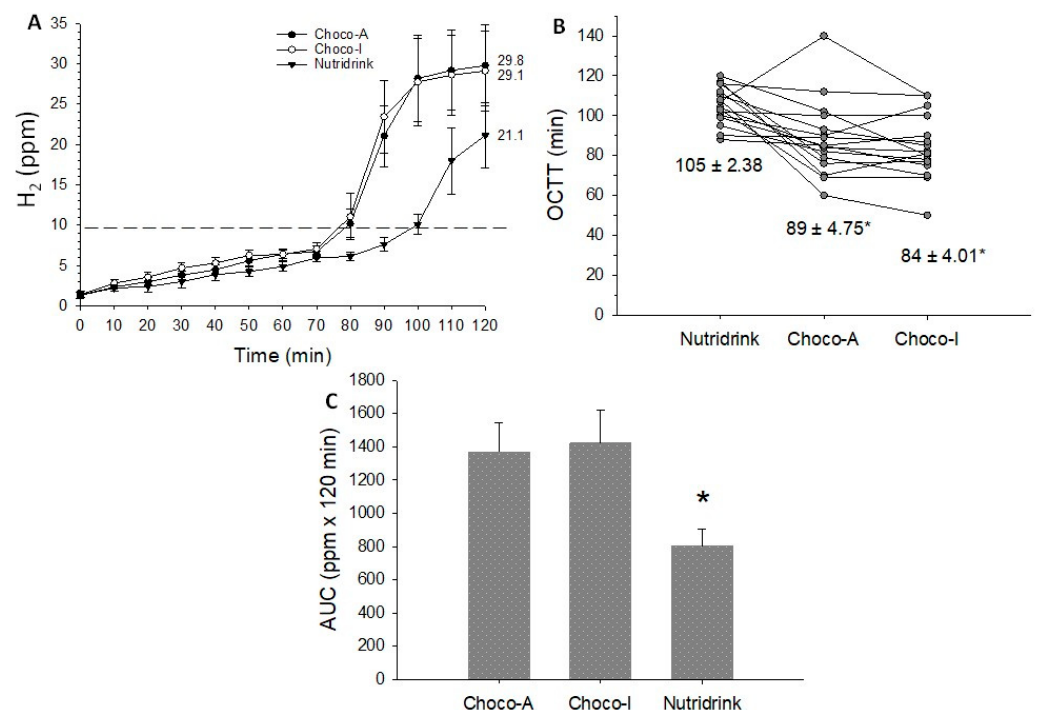
Figure 7. Orocecal transit / colonic fermentation parameters in response to ingestion of chocolates and test meal. ( A ) Time-dependent changes of H 2 levels (ppm) in exhaled air; ( B ) Orocecal transit time (OCTT) as individual values and mean ± SEM reported below; ( C ) Area under H 2 curve (AUC). Data are expressed as means ± SEM. * p < 0.05 vs. Choco-A and